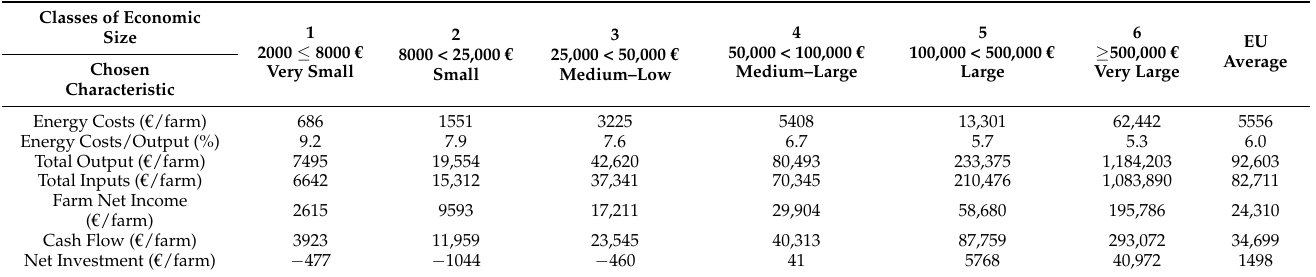
Table 3. Energy costs and other financial information of farms according to the farm’s economic size in the European Union * in 2020.